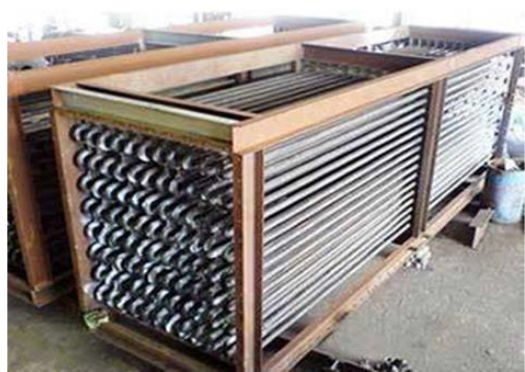
Figure 5. Water heater module of Degetron Engineering [17].